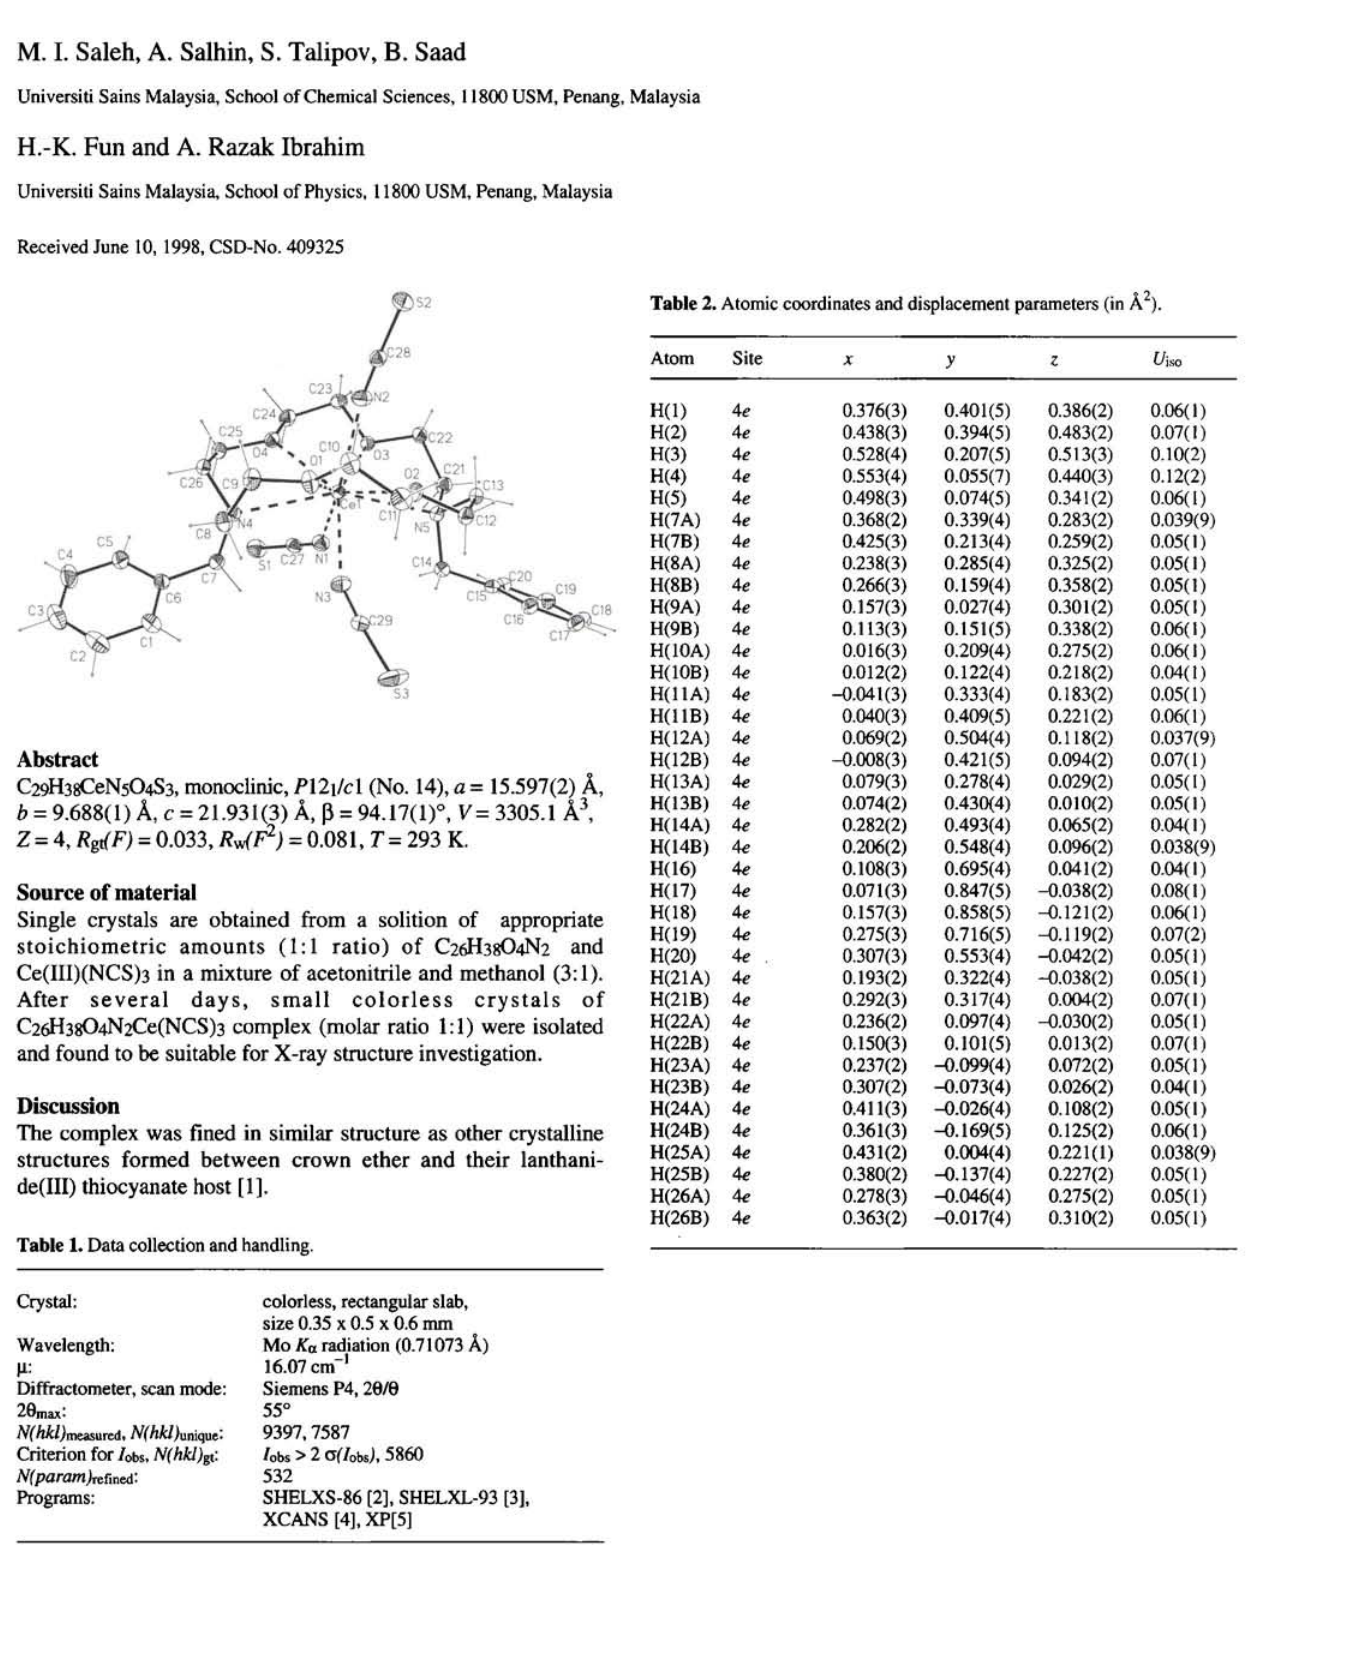
Table 2. Atomic coordinates and displacement parameters (in À 2 ).